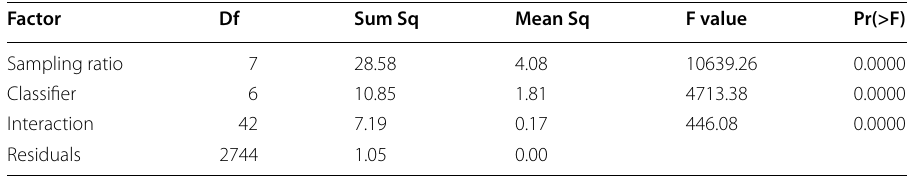
Table 15 ANOVA results for 2-factor test of classifier and sampling ratio, including their interaction; in terms of